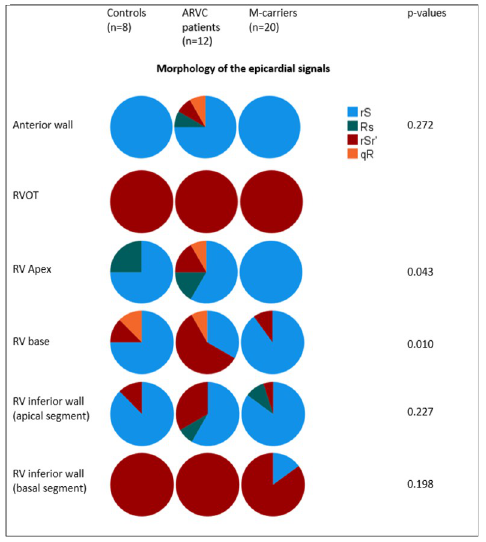
Fig 4. Epicardial depolarisation signal morphology per study group and area of interest. The figure summarizes the morphology of the epicardial QRS complexes, per study group and area of interest. The size of the pie chart reflects its proportional size. The p-values refer to the comparison between the three study groups with Kruskal-Wallis test. RV = right ventricle, RVOT = right ventricle outflow tract.